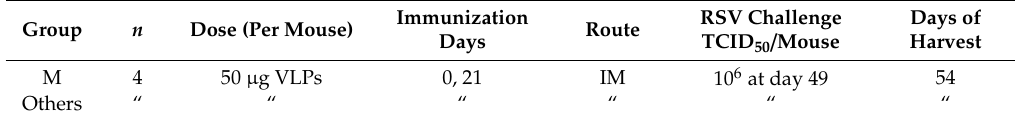
Table 2. Immunization schedule. Mice were divided into seven groups and immunized as shown above and in Figure 4A. Other groups: MFP, MFGP, MFG P P, MFM2-1, MFGM2-1, or MFG P M2-1. IM, intramuscular.